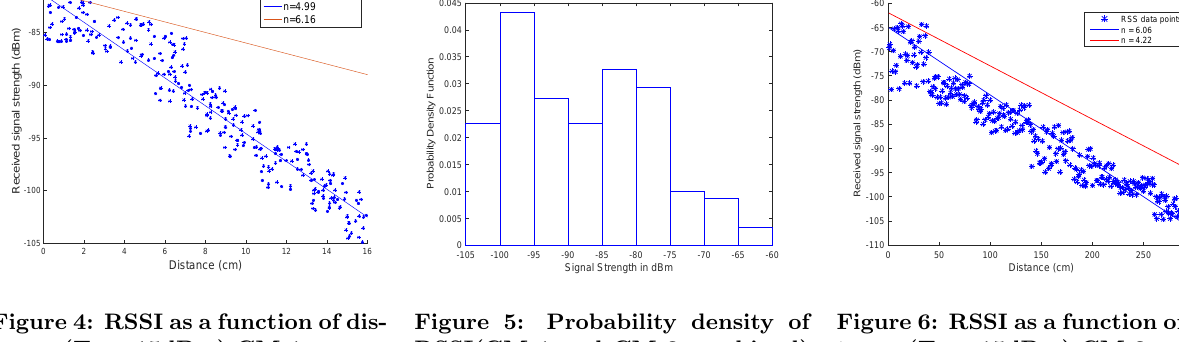
Figure 4: RSSI as a function of dis- tance (Tx=-15dBm) CM 1